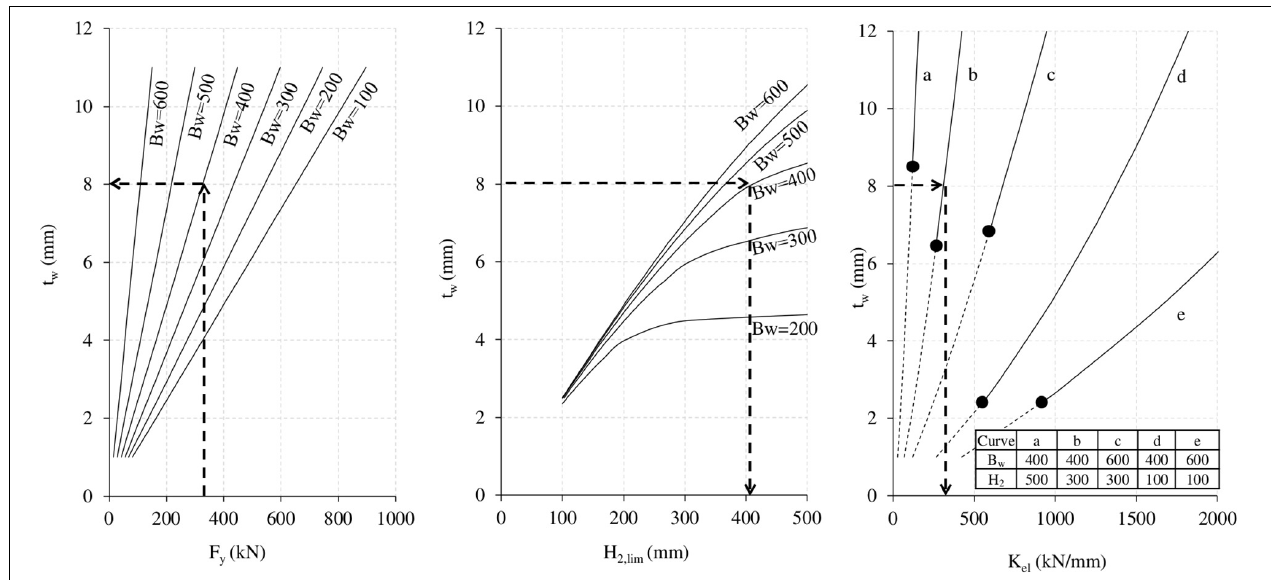
FIGURE 7 | Preliminary design chart of SL devices (S235 steel grade; B w and H 2 expressed in mm).